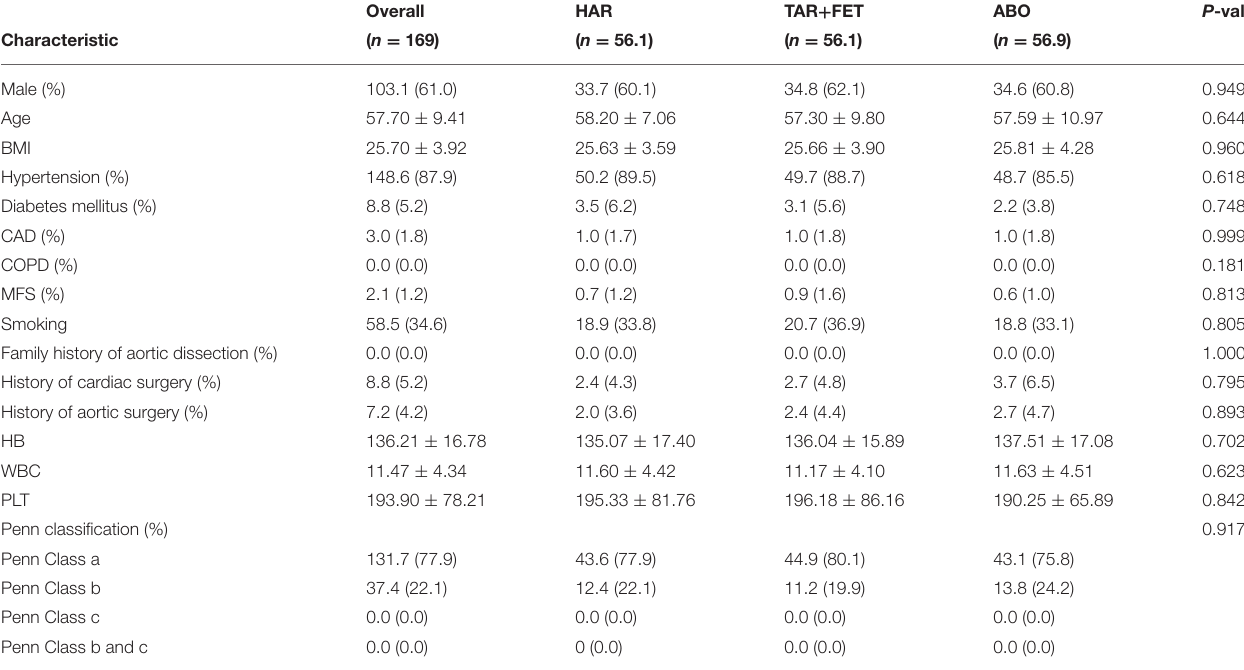
TABLE 2 | Preoperative characteristics of the total cohort and each group after using the matching weight method. Overall HAR TAR + FET ABO P